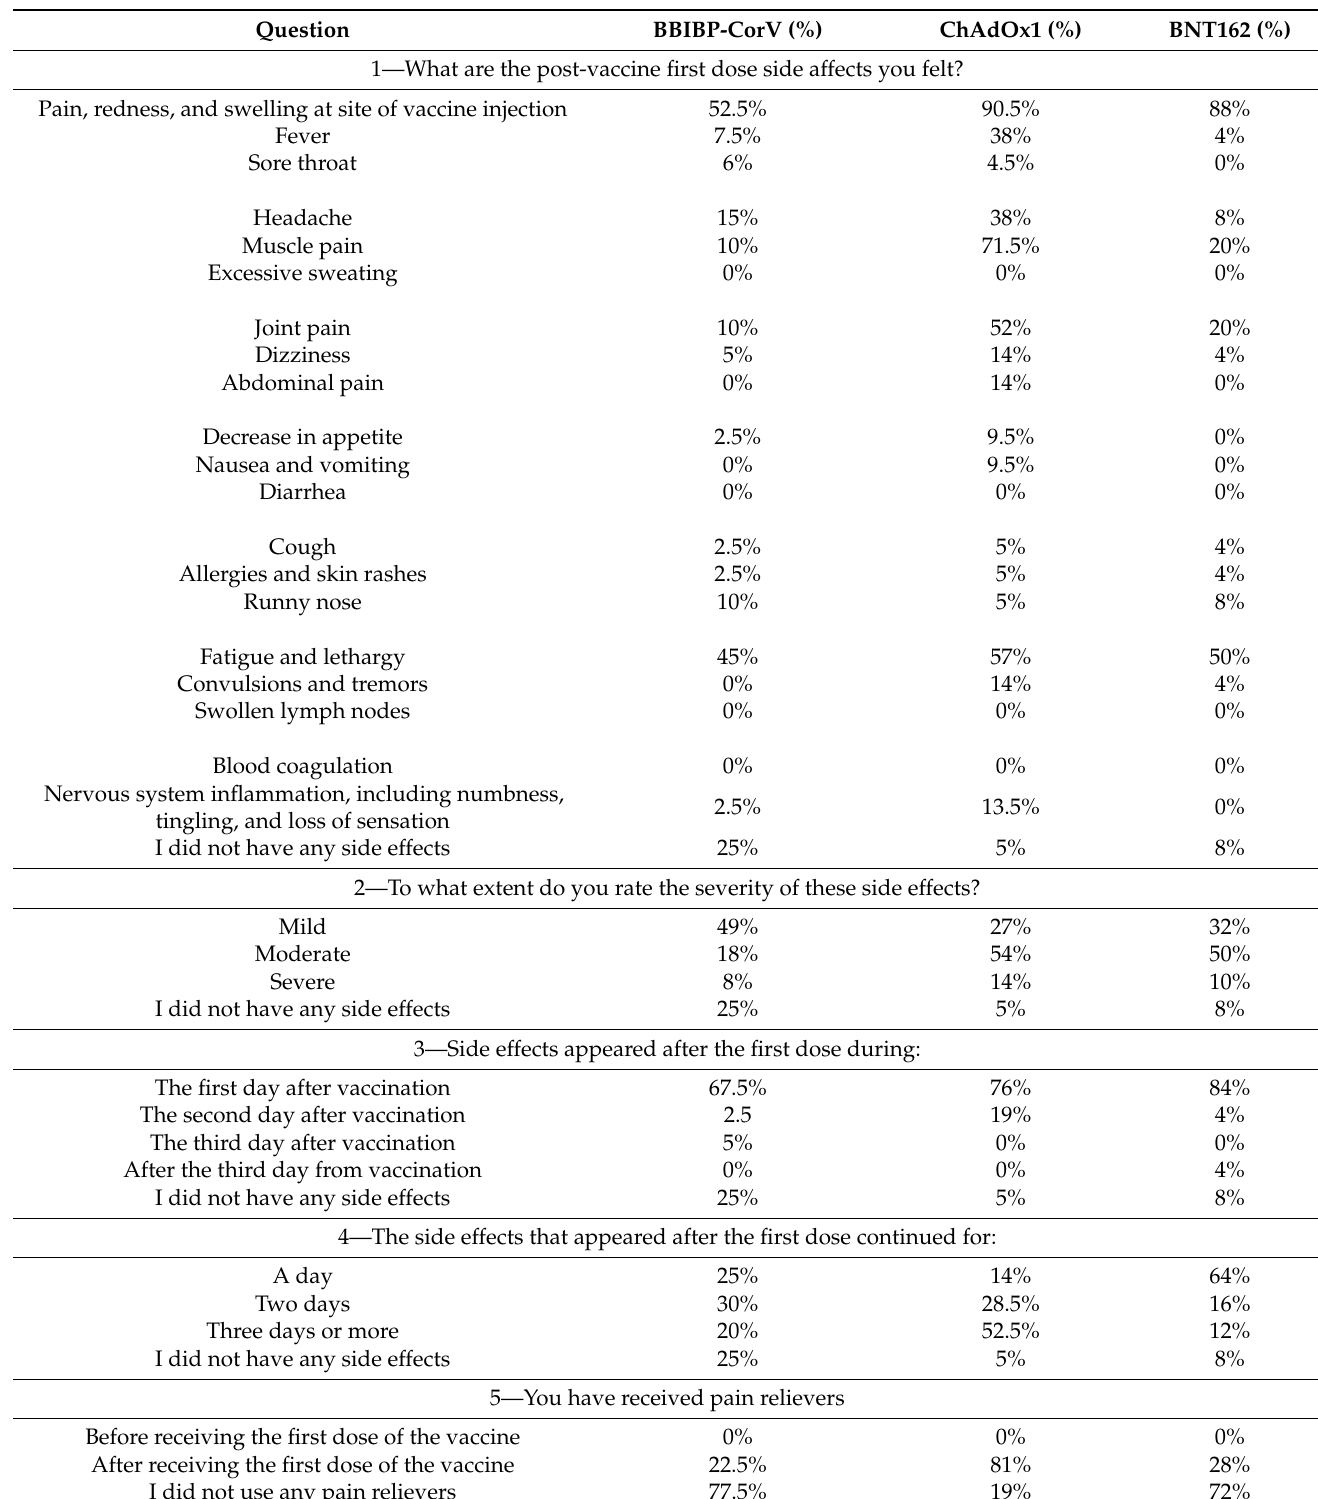
Table 2. Postvaccine first-dose side effects and